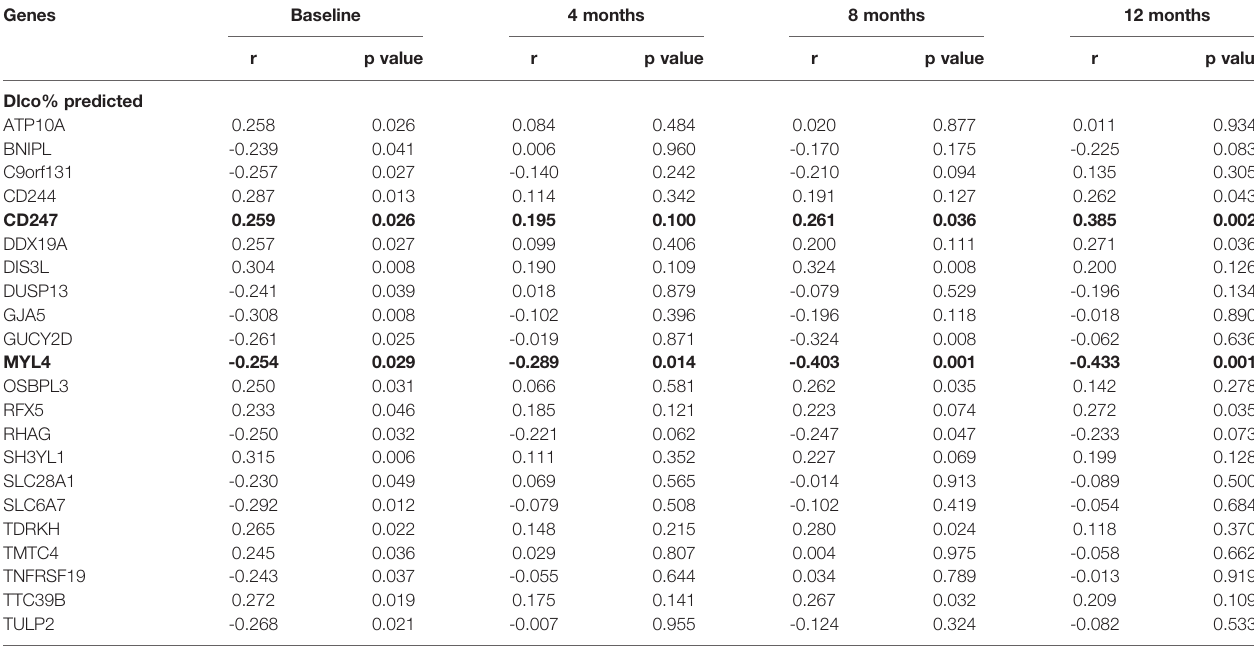
TABLE 3 | The correlations between gene expression and Dlco% predicted or FVC% predicted after visiting at 4, 8, and 12 months in the GSE132607 dataset. Genes Baseline 4 months